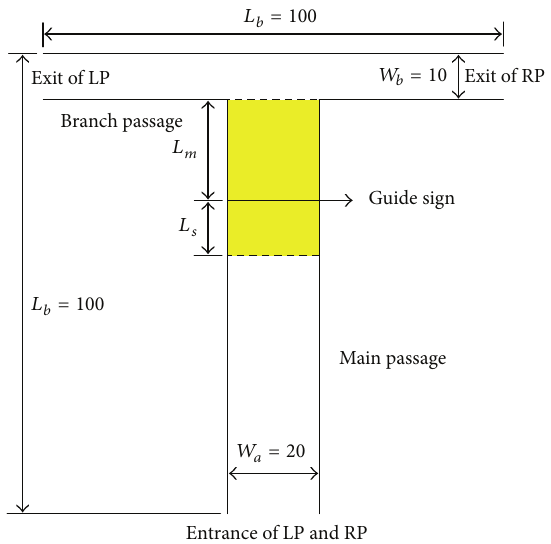
Figure 2: Schematic diagram of the position of guide sign.